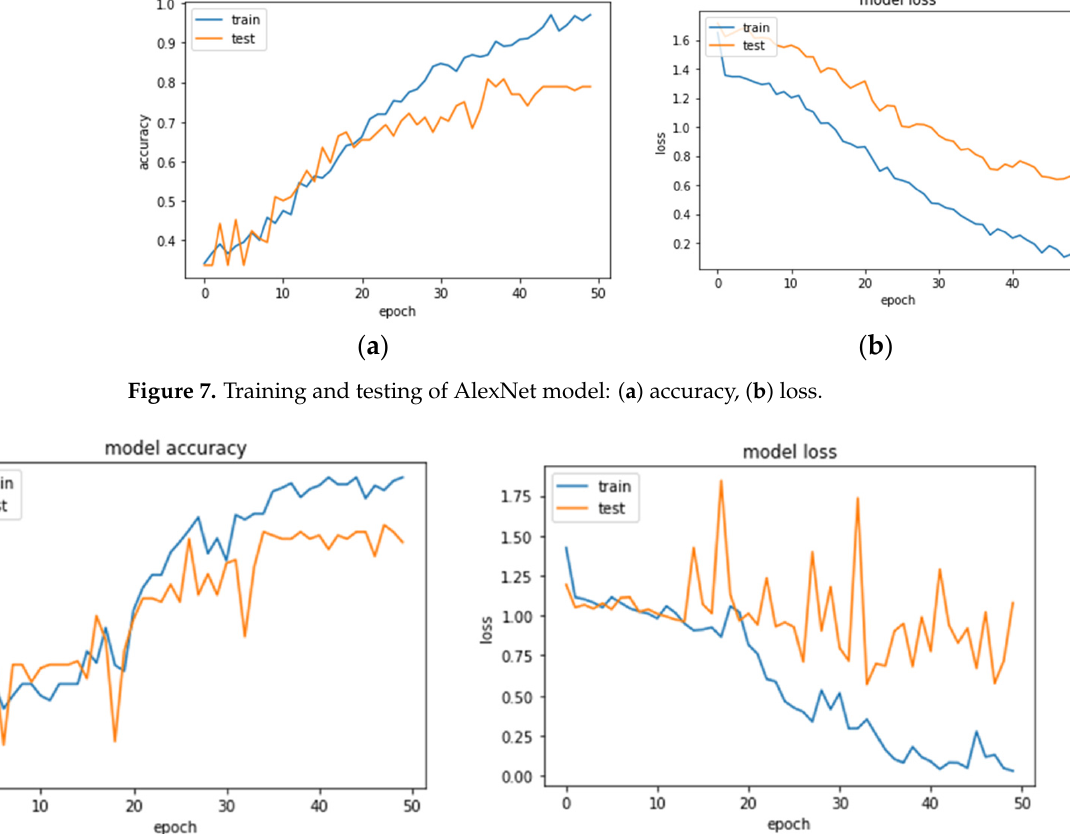
Table 6. Summary of AlexNet transfer learning results.